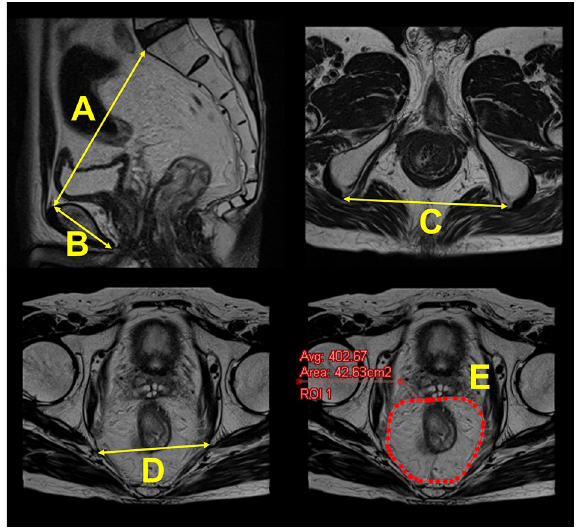
Figure 3. Magnetic resonance imaging pelvimetry. (A) Pelvic inlet (distance between the sacral promontory and superior aspect of the pubic symphysis). (B) Pubic tubercle height (distance from the superior to the inferior middle aspect of the pubic symphysis). (C) Intertuberous distance (distance between the lowest points of the ischial tuberosities). (D) Interspinous distance (distance between the tips of the ischial spines). (E) Mesorectal fat area at the level of the tips of the ischial spines (red